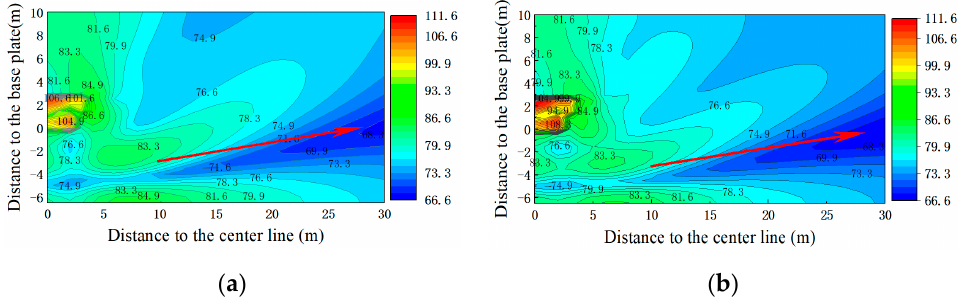
Figure 13. Sound pressure level of transverse sound field of box girder (dB); ( a ) condition 1; ( b ) condition 2.